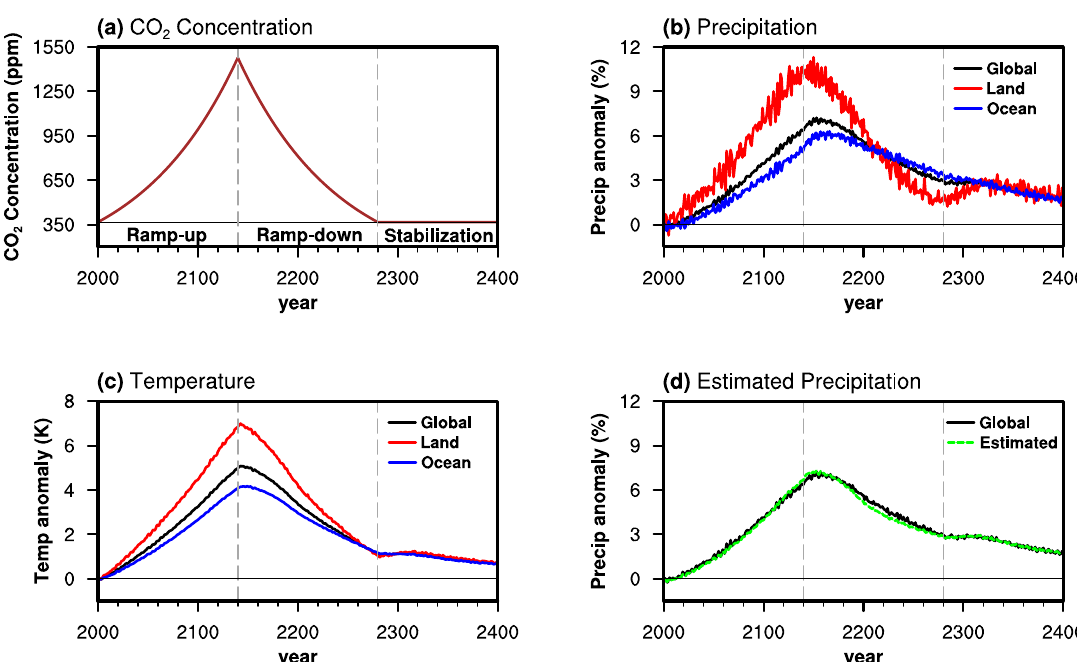
Fig. 1 Mean precipitation and temperature changes for a changing CO 2 pathway. a Changes in CO 2 concentration for an increase (ramp- up) period, a decrease (ramp-down) period, and a stabilization period. b Changes in global, land, and ocean mean precipitation from the ramp-up period to the stabilization period compared to the PD simulation. c Same as b , except for surface temperature anomaly. d Changes in global mean precipitation from the ramp-up period to the stabilization period compared to the PD simulation (black) and the estimated global mean precipitation (green) using a simple conceptual model (see “ Methods ”